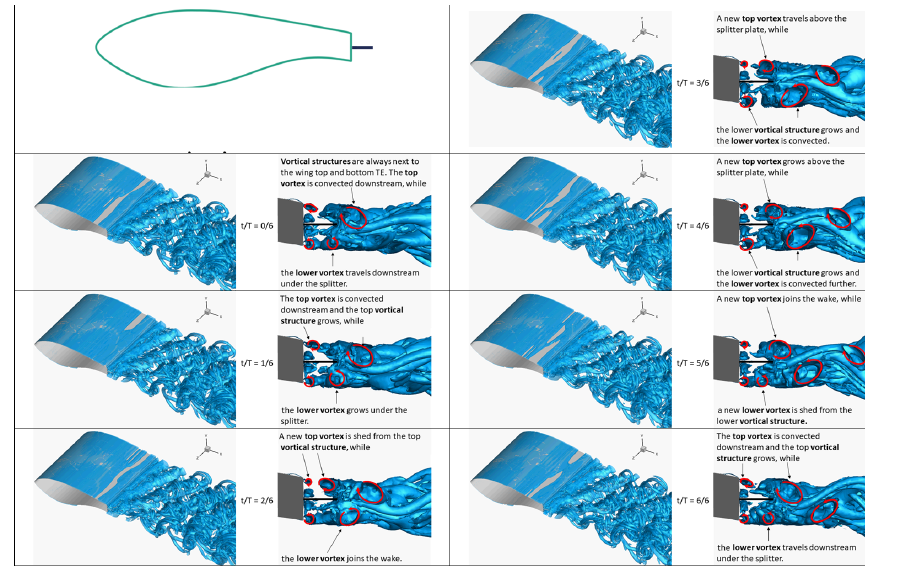
Figure A2. Snapshots of Q isosurfaces from the splitter case: IDDES fine-mesh results. Each period of the vortex shedding mechanism is split into six parts, and a total of seven snapshots is shown. For each snapshot, two visualisations are shown.A 3D view of Q = 1 . 5 isosurfaces is shown on the left, and a side view of Q = 100 isosurfaces is shown on the right. Superimposed red arrows indicate interpreted spanwise